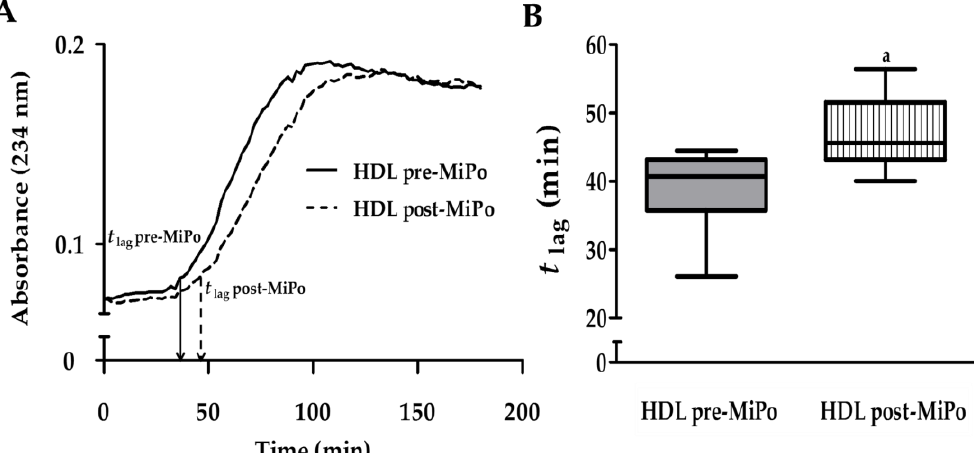
Figure 2. Effect of MiPo on the resistance to oxidation of HDL. The conjugated dienes formation catalyzed by Cu 2+ was determined within HDL from rabbits, before (pre-MiPo) and after (post-MiPo) supplementation with microencapsulated pomegranate. ( A ) Kinetics of conjugated dienes formation determined by spectrophotometry at 234 nm; the curves represent the calculated mean of the individual kinetics pre-MiPo (solid line, n = 6 ) and post-MiPo (dashed line, n = 6 ), normalized to the same initial value. ( B ) Calculated lag time ( t lag ); horizontal lines and boxes represent the median and interquartile range, respectively. Mann–Whitney U test, a p < 0.05, pre- vs. post-MiPo.